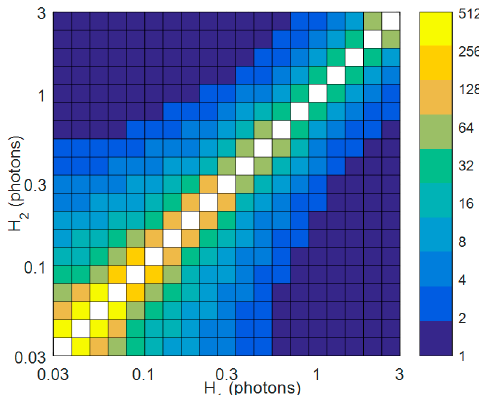
Figure 4. Heat map of the temporal aggregation N t required (in terms of powers of two) to detect a change of photon rate from H 1 to H 2 with >90% sensitivity. The photon rates are specified in terms of the mean detected photons per jot over a sub-exposure (bit-plane) and are presented on logarithmic scales. A spatial aggregation of 8 × 8 is assumed, with each data point on the heat map being obtained using Monte Carlo simulations (under the assumption of Poisson statistics) by generating 10,000 pairs of aggregated pixel realizations (from H 1 and H 2 ) at different levels of N t , and applying Equation (2).